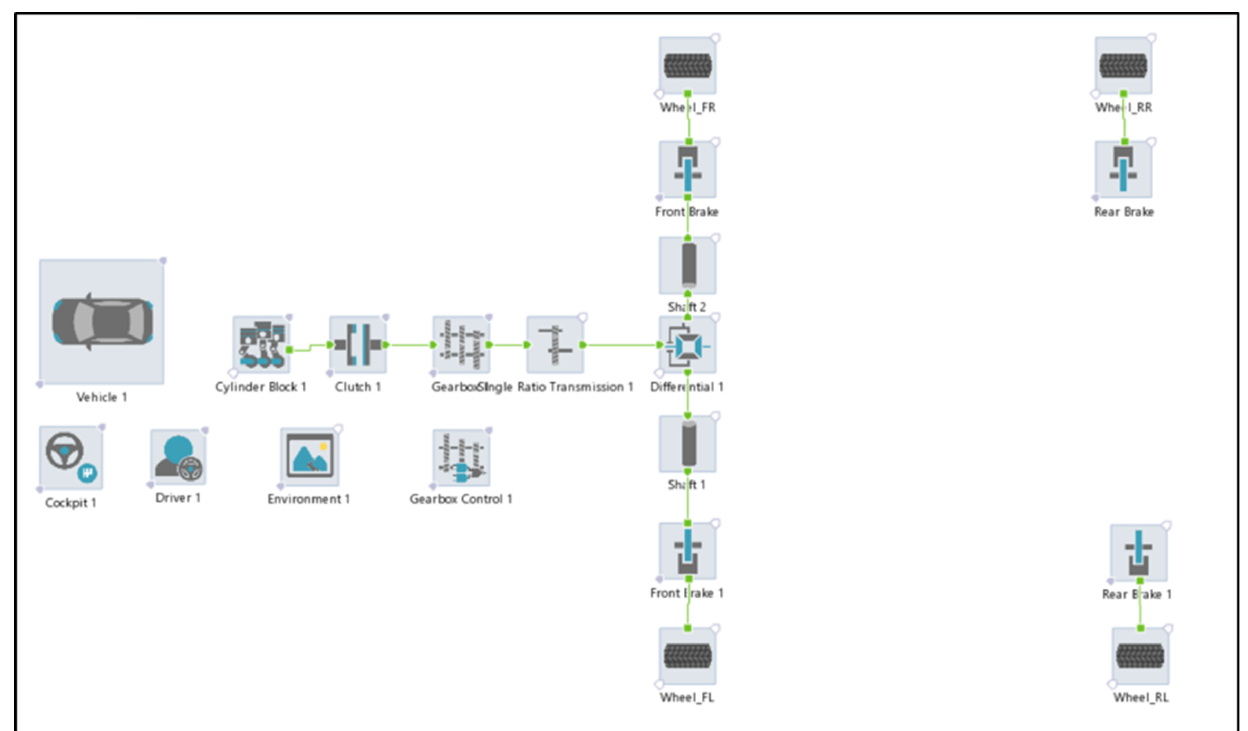
Figure 7. AVL CruiseM TM ICE vehicle model.